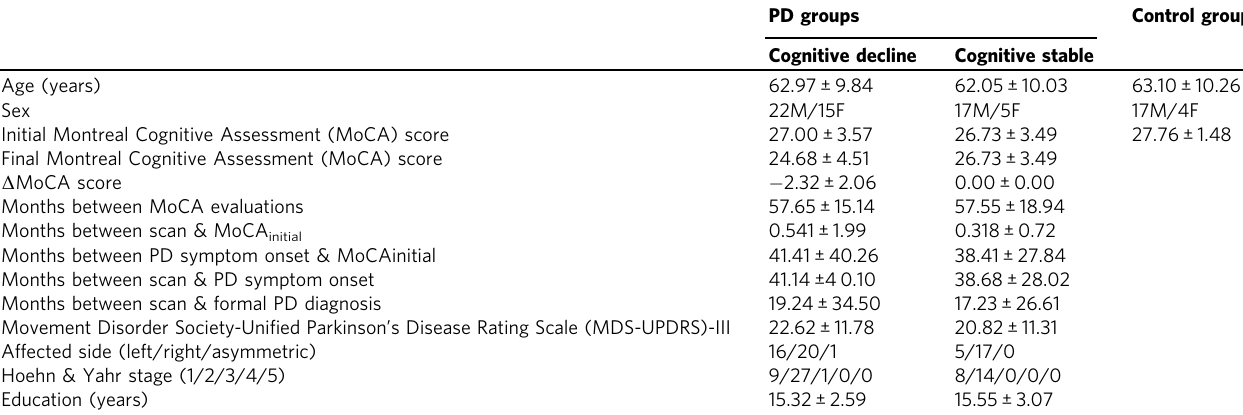
Table 1 Demographic and clinical characteristics of Parkinson ’ s disease (PD) and control